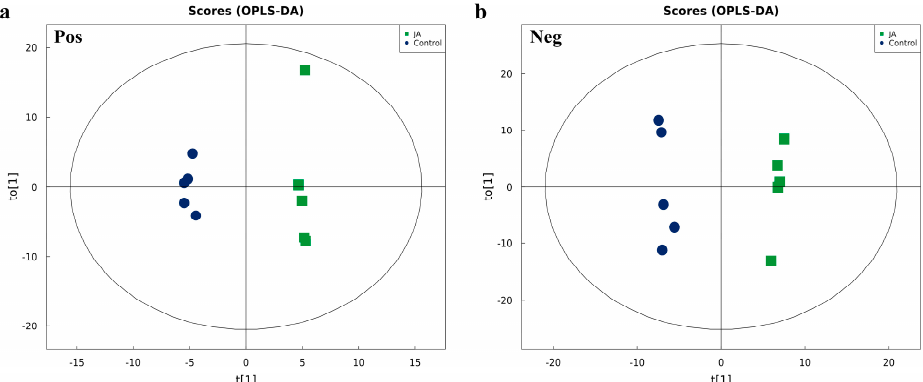
Figure 4. Orthogonal partial least squares discriminant analysis (OPLS-DA) score plot of jasmonic acid-treated and control samples. ( a ) Positive ion mode (Pos); ( b ) negative ion mode (Neg). The abscissa t[1] represents principal component 1, the ordinate t[1] represents principal component 2, and the ellipse represents the 95% confidence interval. Dots of the same color represent each biological replicate within a group, and dot distribution reflects the degree of difference between and within